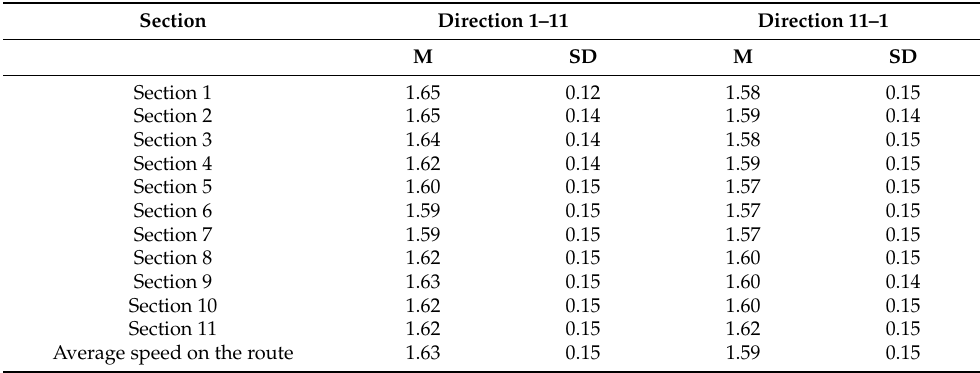
Table 1. The average walking speeds (m/s) in specific sections of the route in Study